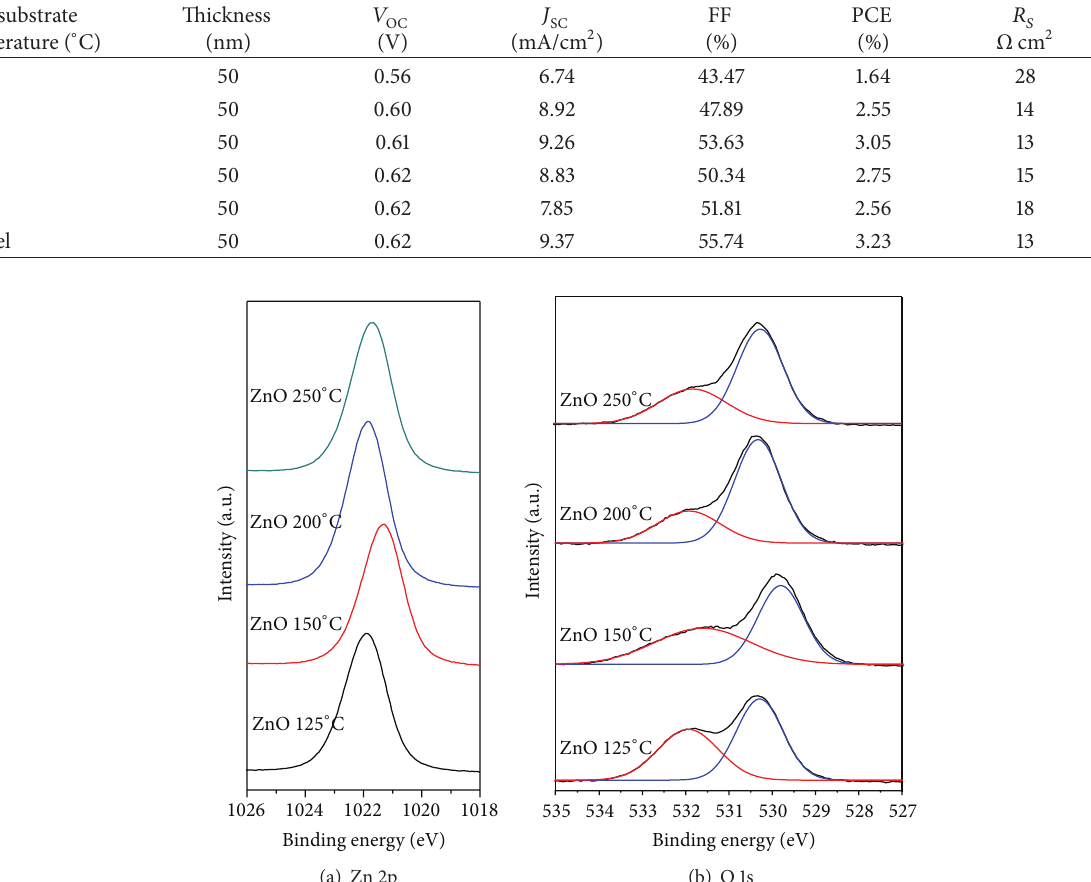
Figure 3: (a) Zn 2p and (b) O 1s XPS spectra of ZnO films fabricated with different substrate